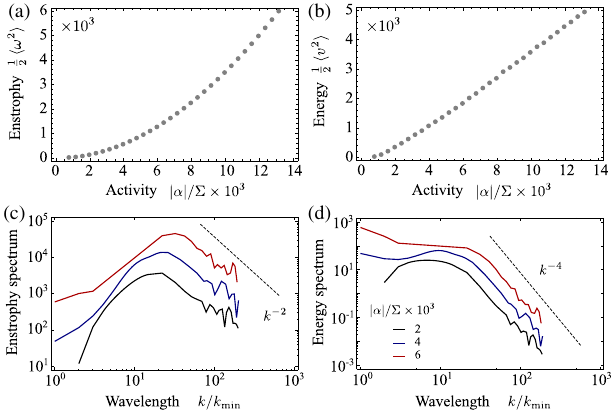
FIG. 5. (a) Enstrophy and (b) energy per unit area versus activity. The data show, respectively, quadratic and linear scaling. (c) Enstrophy and (d) energy spectra for three activity values. The 2 π =L wavelength is normalized to unity at k min ¼